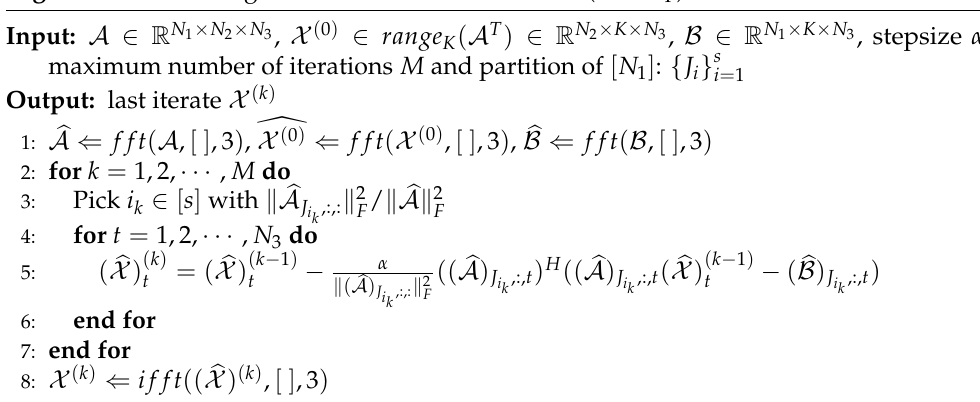
Algorithm 7 TRAK algorithm in the Fourier domain (TRAK F